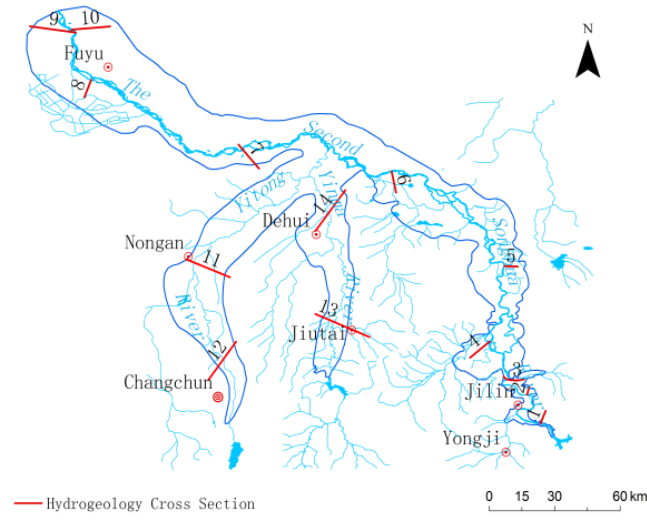
Figure 16. Location of hydrogeology cross